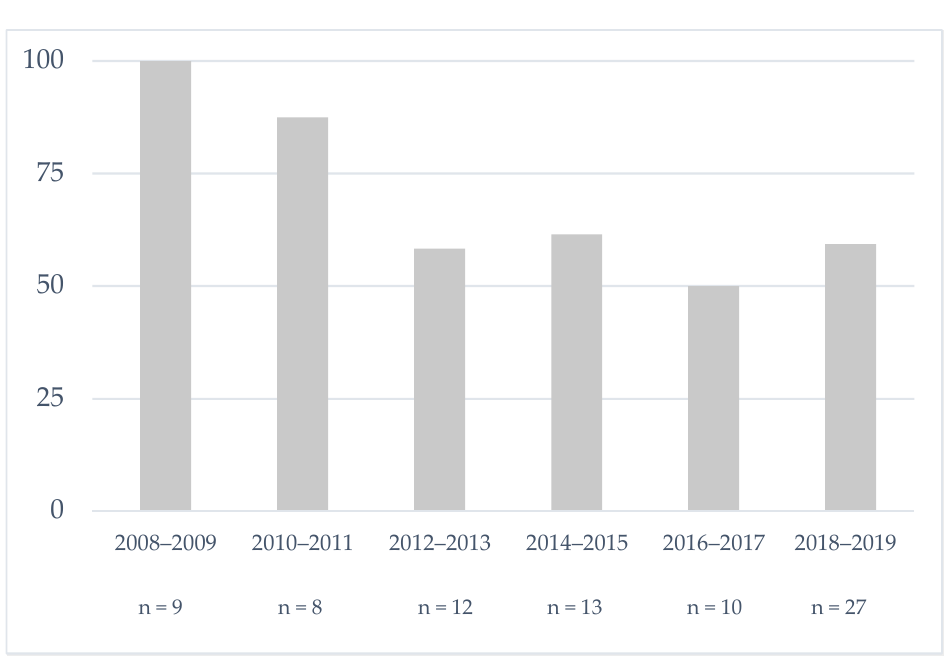
Figure 1. Evolution of the percentage of sickle cell patients who received pre-cholecystectomy prophylactic transfusion in our center.